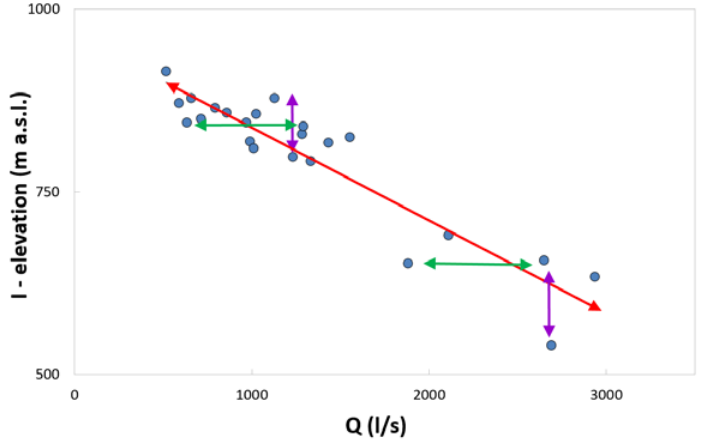
Figure 5. Conceptual model: higher flow rates associated with higher recharge areas, involving lower altitude areas (red arrow). Secondary behaviors: different flow rates associated with the same average recharge area elevation (green arrows); same flow rate associated with different average recharge area elevations (purple arrows).